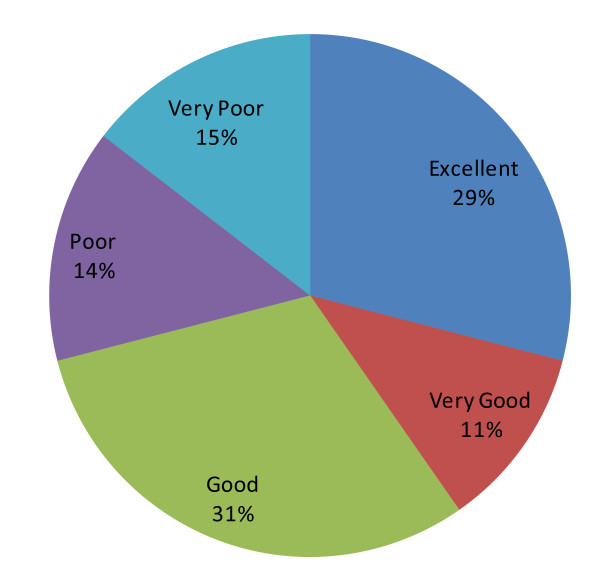
SRH response groups.